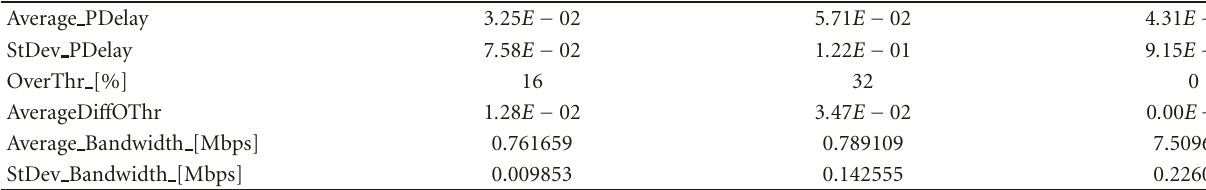
Table 1: Variable tra ffi c: average performance.